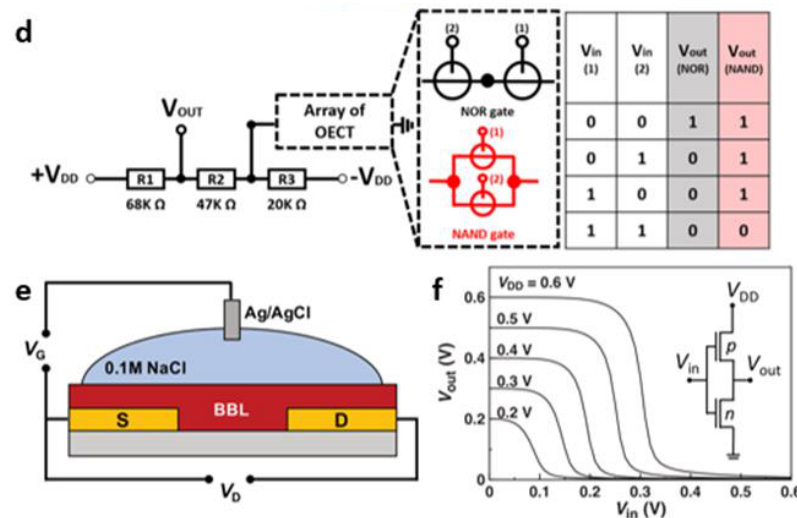
Figure 2. OECT-based digital thin-film circuits. ( a ) An optical microscopy image of 760 OECTs and a single device fabricated on a flexible substrate, and an introduction to each layer (adapted from [ 44 ] with permission from Springer Nature). ( b ) Schematic and optical image of gelatin electrolyte-based OECT and ( c ) its output curve. ( d ) Schematic and truth table of NOR and NAND gates in which two gelatin-OECTs were configured in series or parallel structure (adapted from [ 45 ] with permission from the American Chemical Society). ( e ) Device schematic diagram of BBL-based n -type OECT. ( f ) Input/output characteristics of complementary inverters implemented with BBL-based n -type OECTs, P3CBBL-based n -type OECTs and P3CPT-based p -type OECTs (adapted from [ 46 ] with permission from John Wiley and Sons).